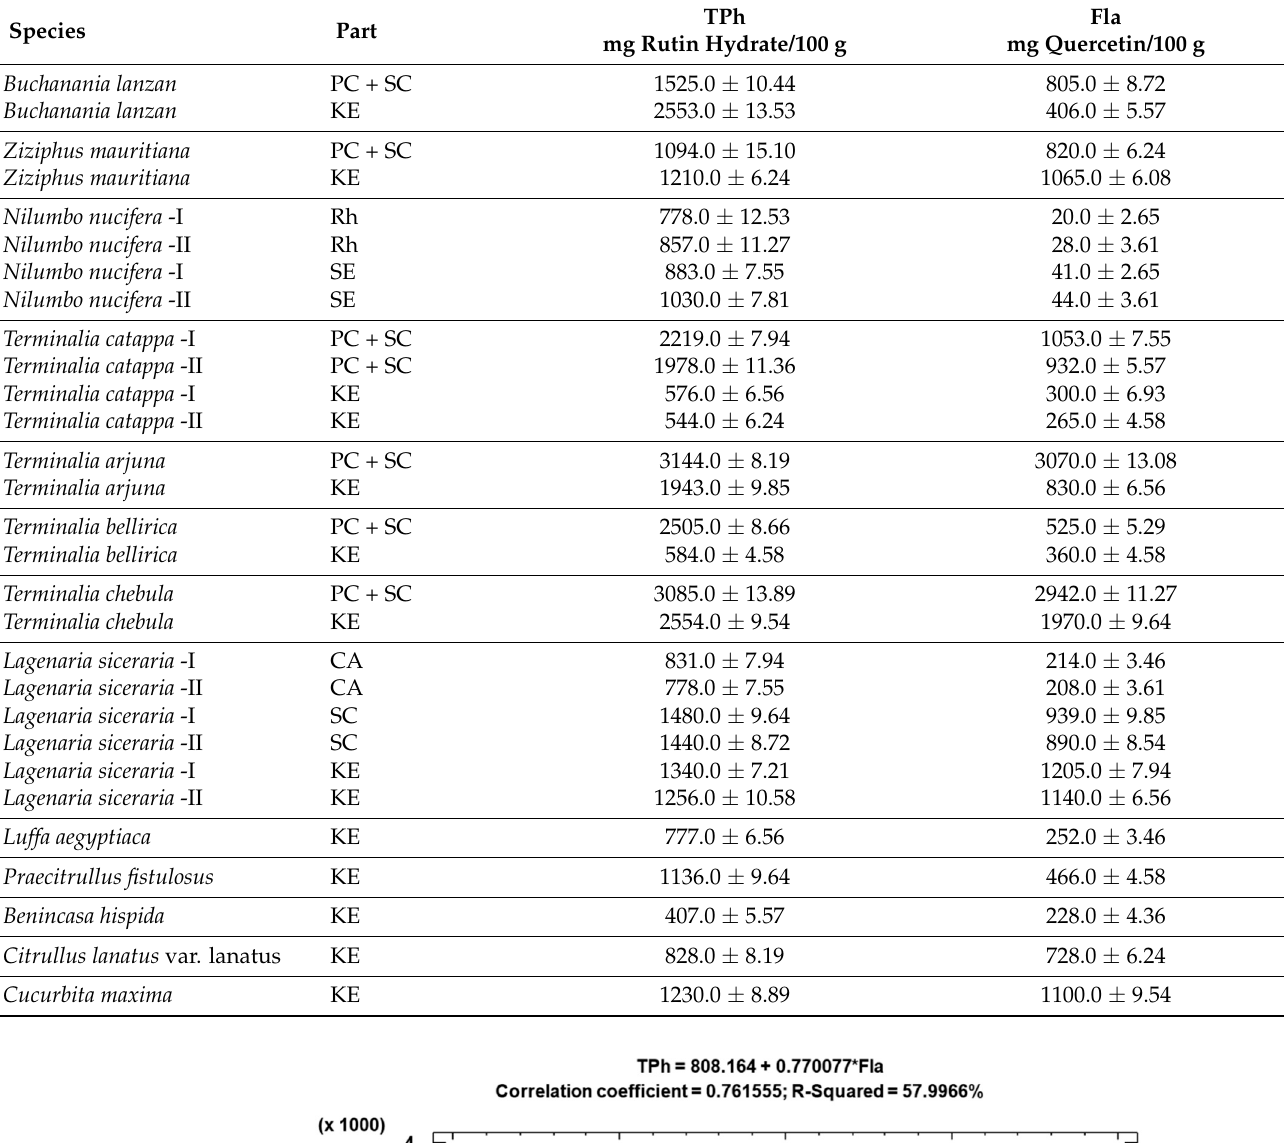
Table 2. Polyphenol content of herbal fruits.